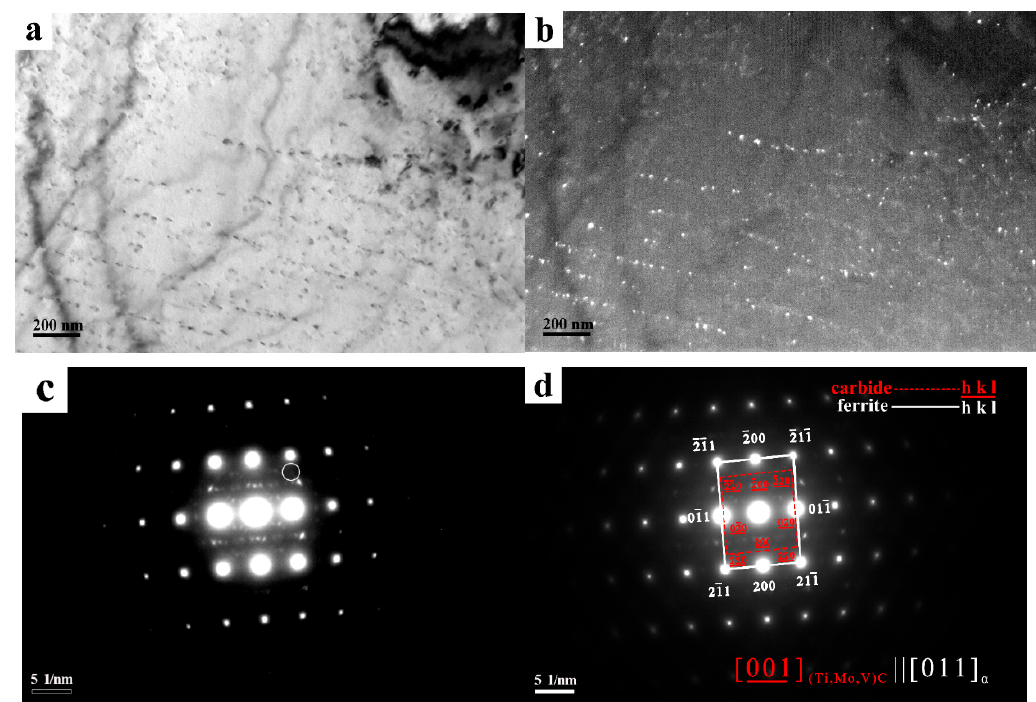
Figure 7. TEM micrographs of steel LC600. ( a ) Bright-field image, ( b ) dark-field image, ( c ) the selected area diffraction pattern (SADP) of interphase precipitation and matrix, (the red circle in figure is the spot selected by the dark-field image) and ( d ) the carbides adapt only one variant of the Baker–Nutting orientation relationship.